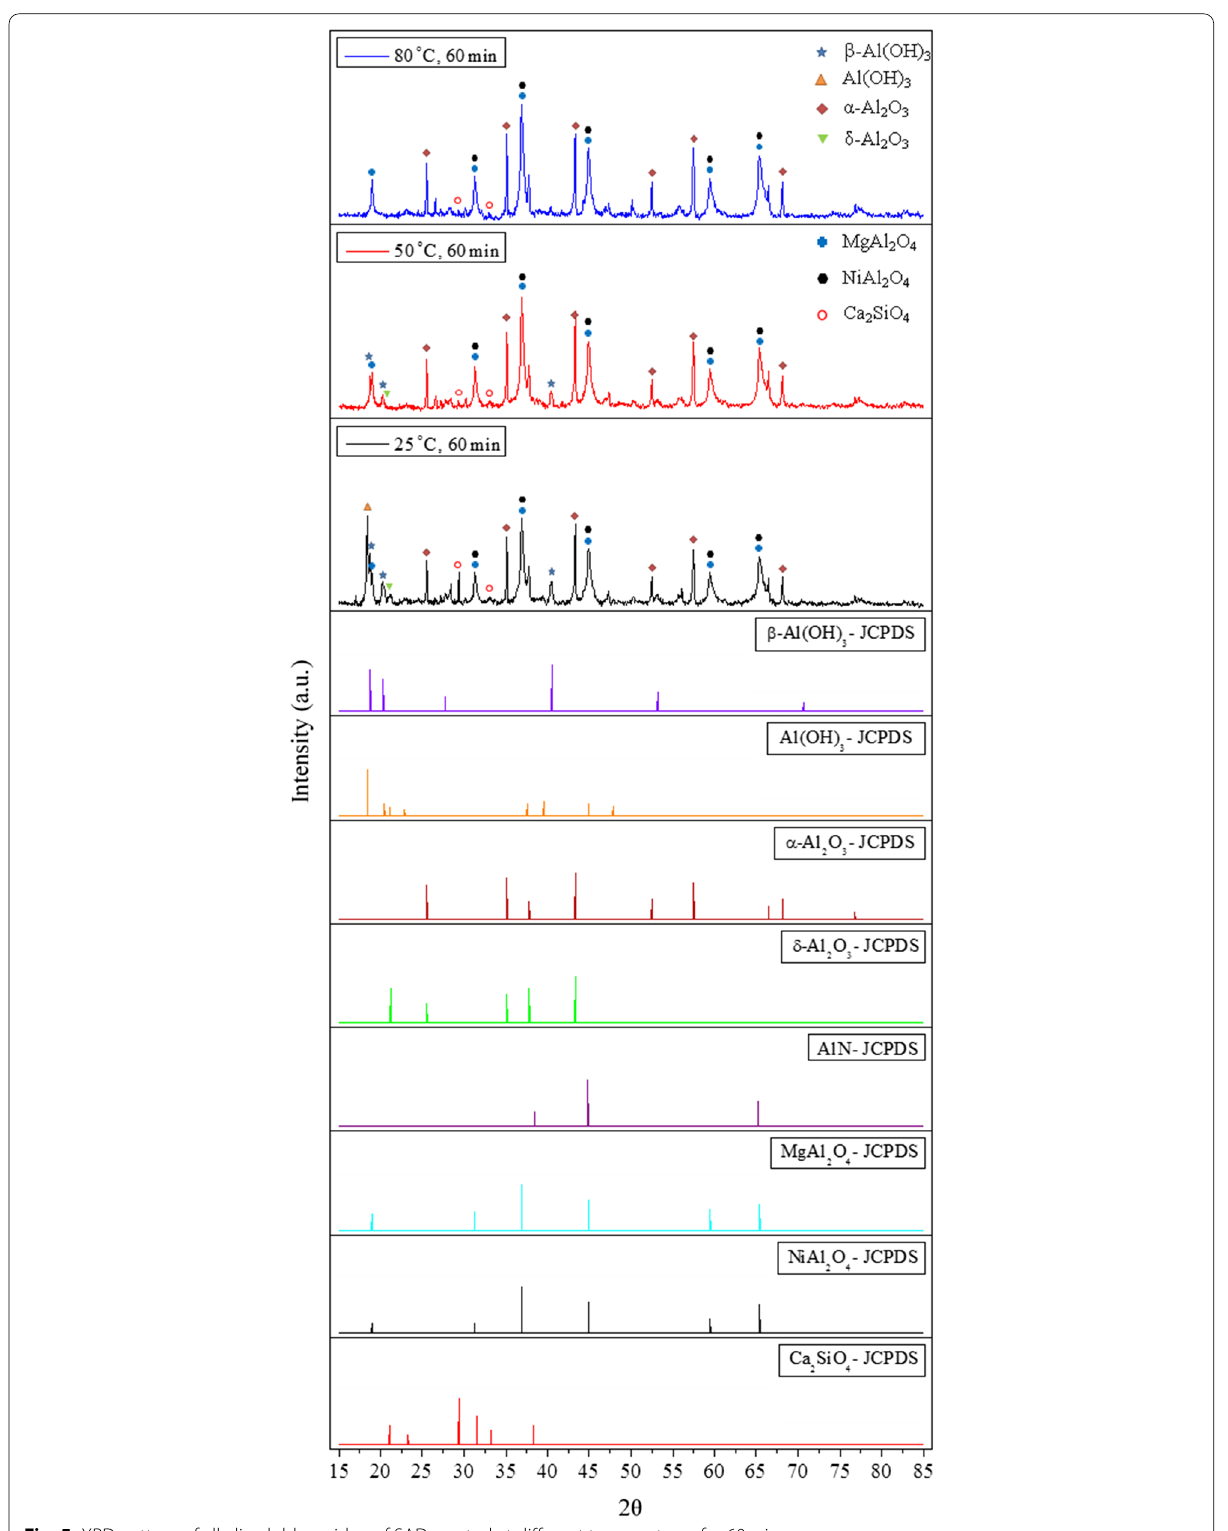
Fig. 5 XRD pattern of alkali‑soluble residue of SAD reacted at different temperatures for 60